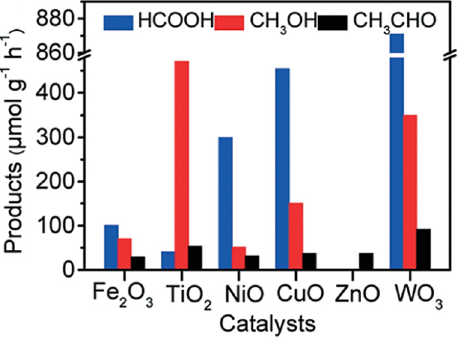
Figure 27. Methanol generation for different catalysts in Fenton reaction [27]. Reproduced with permission from Zeng et al. Copyright © 2022 The Royal Society of Chemistry.